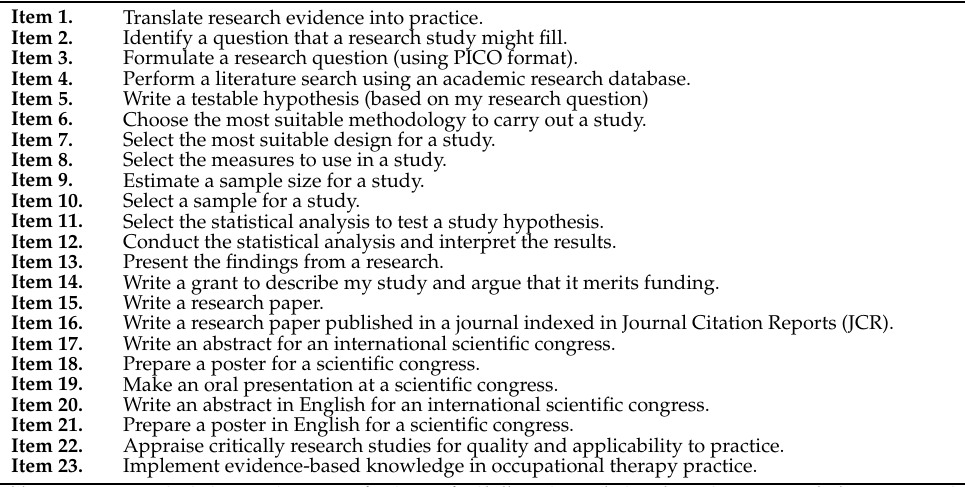
Table 1. Summary of the items * to test research skills included in the HACTO-Screen survey. Item 1.